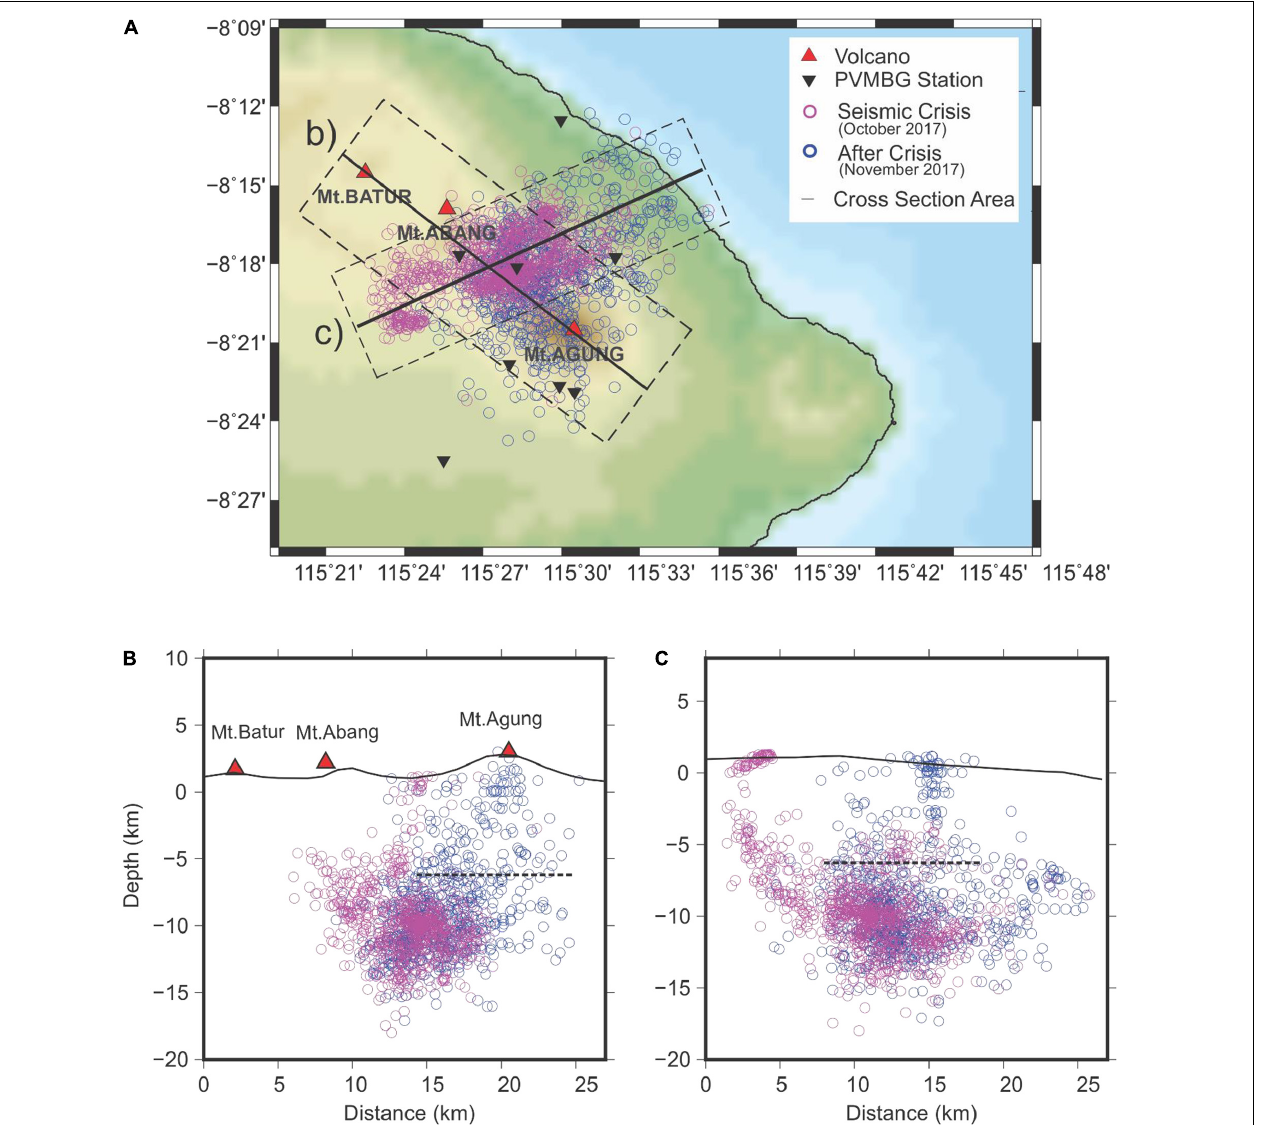
FIGURE 10 | (A) Distribution of epicenters. (B,C) Map of the vertical distribution of the VT events preceding the 2017 Agung volcanic eruption in two vertical cross-sections. The two cross-sections are shown in the epicenter map in (A) . Purple and blue circles represent events during and after seismic crisis respectively, respectively. The dashed black horizontal line at 6 km depth represent the interpreted depth boundary described in the